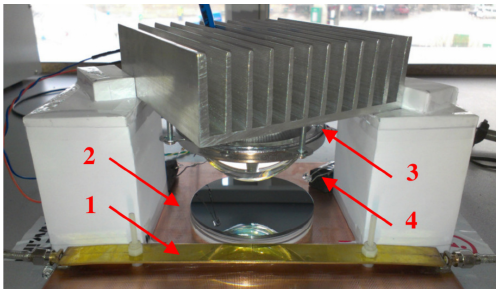
Figure 1: An experimental setup including a strip line (1), a WGM resonator (2), a heat sink with an LED and a light focusing lens (3), and a pin-diode photo-detector (4).